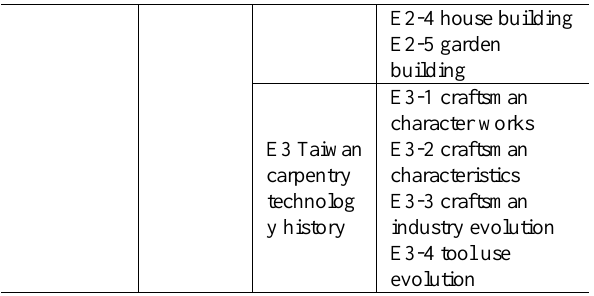
Table 3 Knowledge system framework of carpentry